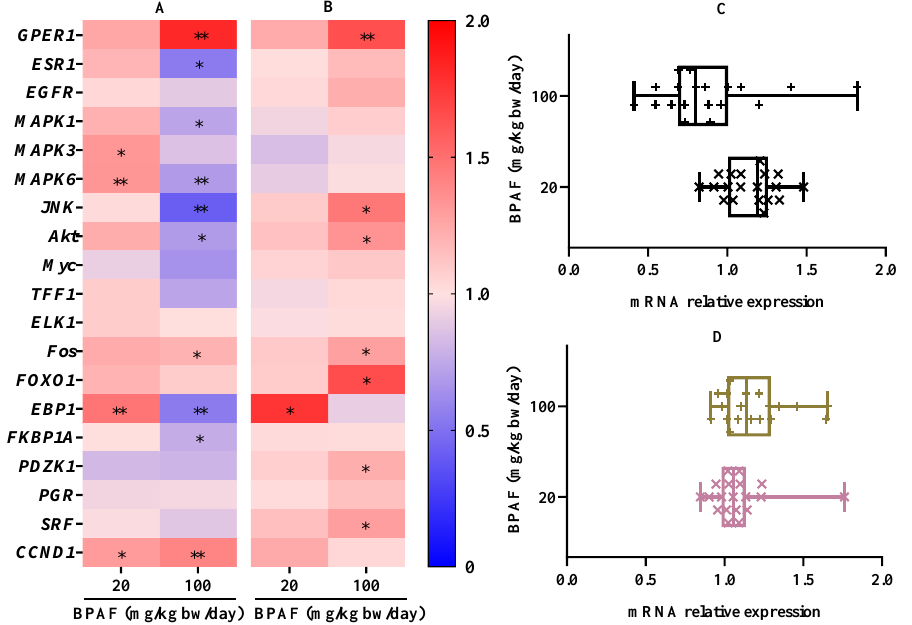
Figure 4. Effect of BPAF exposure for 15 days on the mRNA relative levels of 19 genes associated with the PI3K/Akt and MAPK pathways in liver and kidney of female nude mice with SK-BR-3 xenograft tumor. ( A ): the mRNA relative expression of 19 genes in liver; ( B ): the mRNA relative expression of 19 genes in kidney; ( C ): the data distribution of mRNA relative levels of 19 genes in liver; ( D ): the data distribution of mRNA relative levels of 19 genes in kidney. The data represented the mean of six parallel mice samples. * p < 0.05 and ** p < 0.01, relative to SK-BR-3 bearing tumor control.